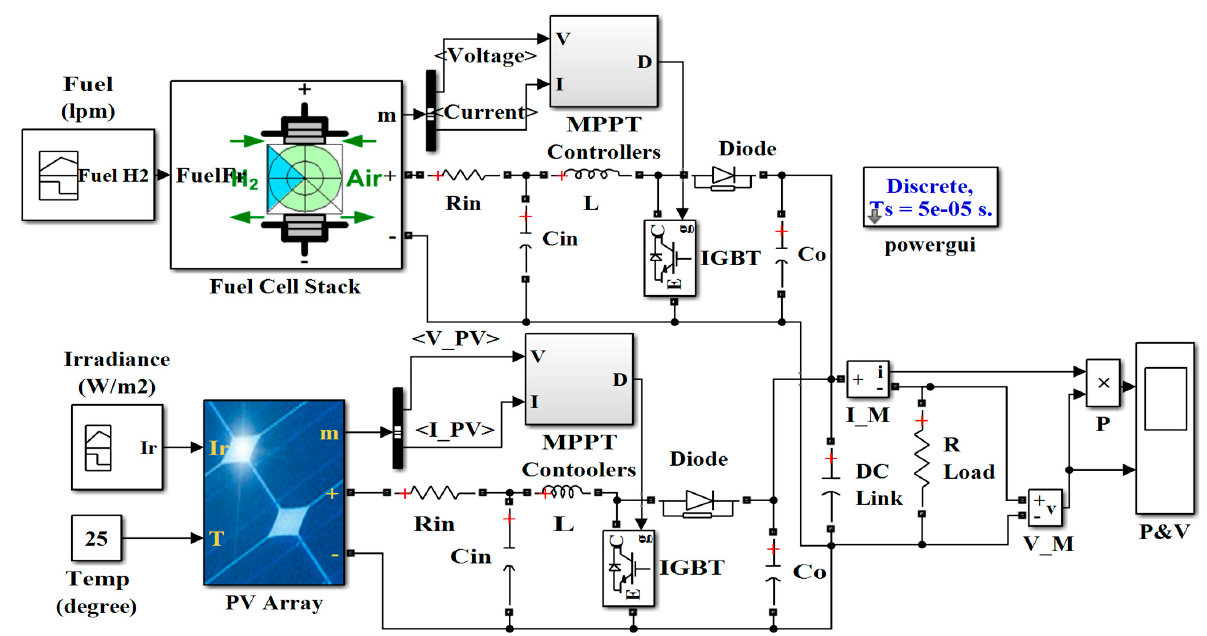
Figure 14. Simulation model of FC system with MPPT controller.